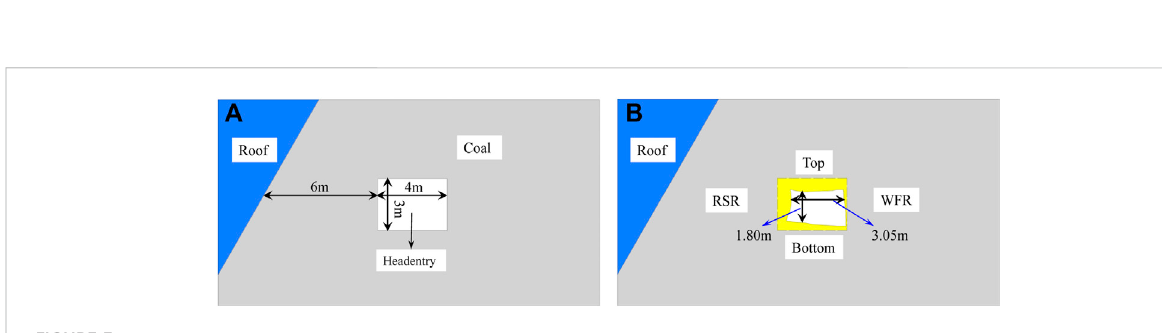
FIGURE 3 Cross-section of the headentry: (A) before the MSTCB, and (B) after the